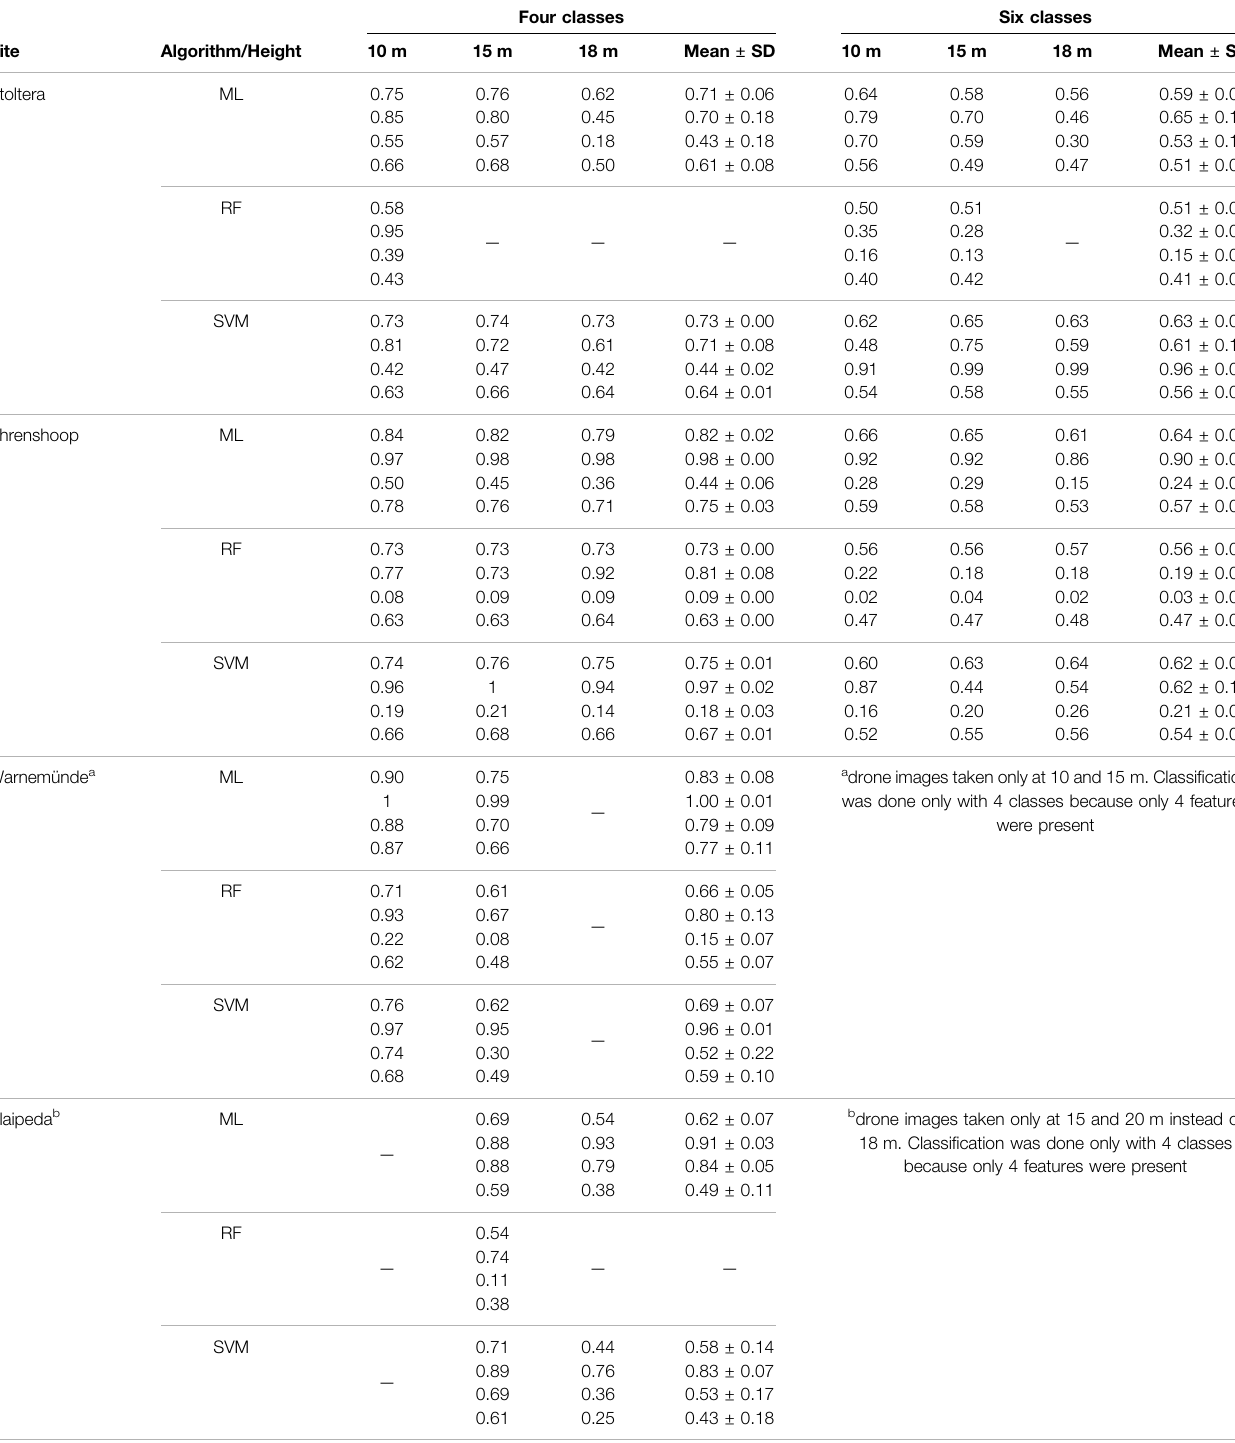
TABLE 1 | Accuracy of image classi fi cation on recovery sites with 4 and 6 classes (litter, vegetation, algae, stones, shells and sand) for each site, algorithm and fl ight height. The values are presented as percentage from top to bottom: Total Accuracy (TA), Producer ’ s accuracy (PA) of litter class, User ’ s accuracy (UA) of litter class and kappa value of agreement